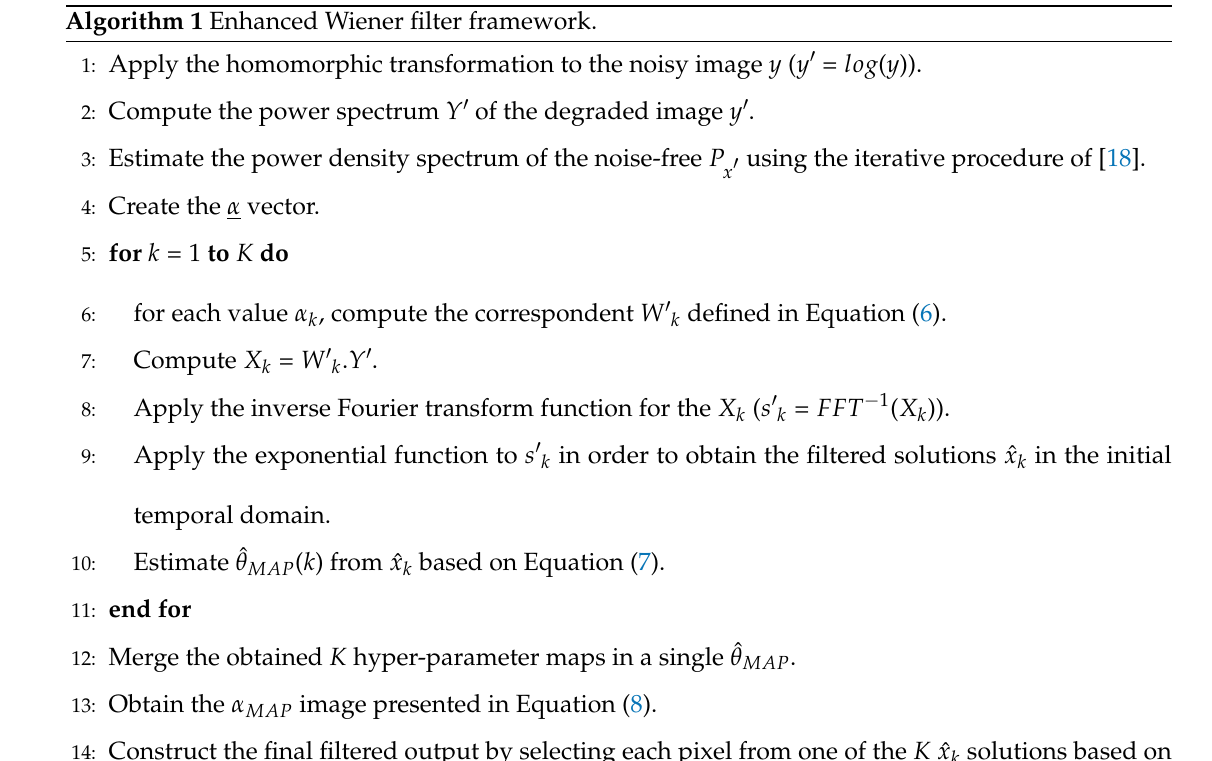
Algorithm 1 Enhanced Wiener filter